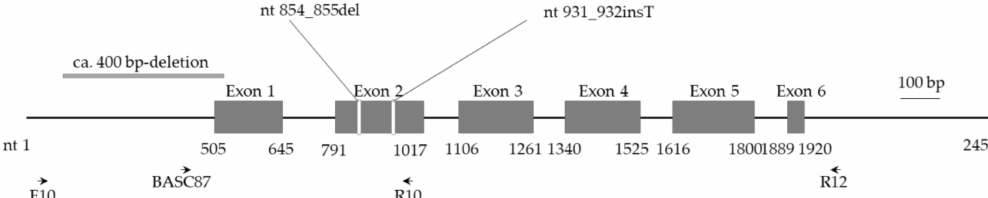
Figure 3. Schematic structure of Asc1 from SLL in the DDBJ/EMBL/GenBank databases identified as accession #AF198177. Asc1 is composed of 6 exons and encodes an ASC1 protein of 308 amino acids. Primers indicated by arrows are listed in Table 2. The primer set BASC87+R12 was used to amplify a ca. 1600-bp fragment containing Asc1 for cloning and sequencing. The primer set F10+R10 was used to detect the ca. 400-bp deletion including the 5 (cid:48) -UTR and part of the 5 (cid:48) ORF of Asc1 . White gaps shown in exon 2 represent a two-nucleotide deletion reported in SLL cv. Aichi-first and found in SLJ PER018894 and SLC M5-3 in this study and a nucleotide insertion found in SP PER018805, respectively. An approximately 400-bp deletion including the upstream region and part of the 5 (cid:48) ORF region indicated by a gray bar has been reported in SC and SG